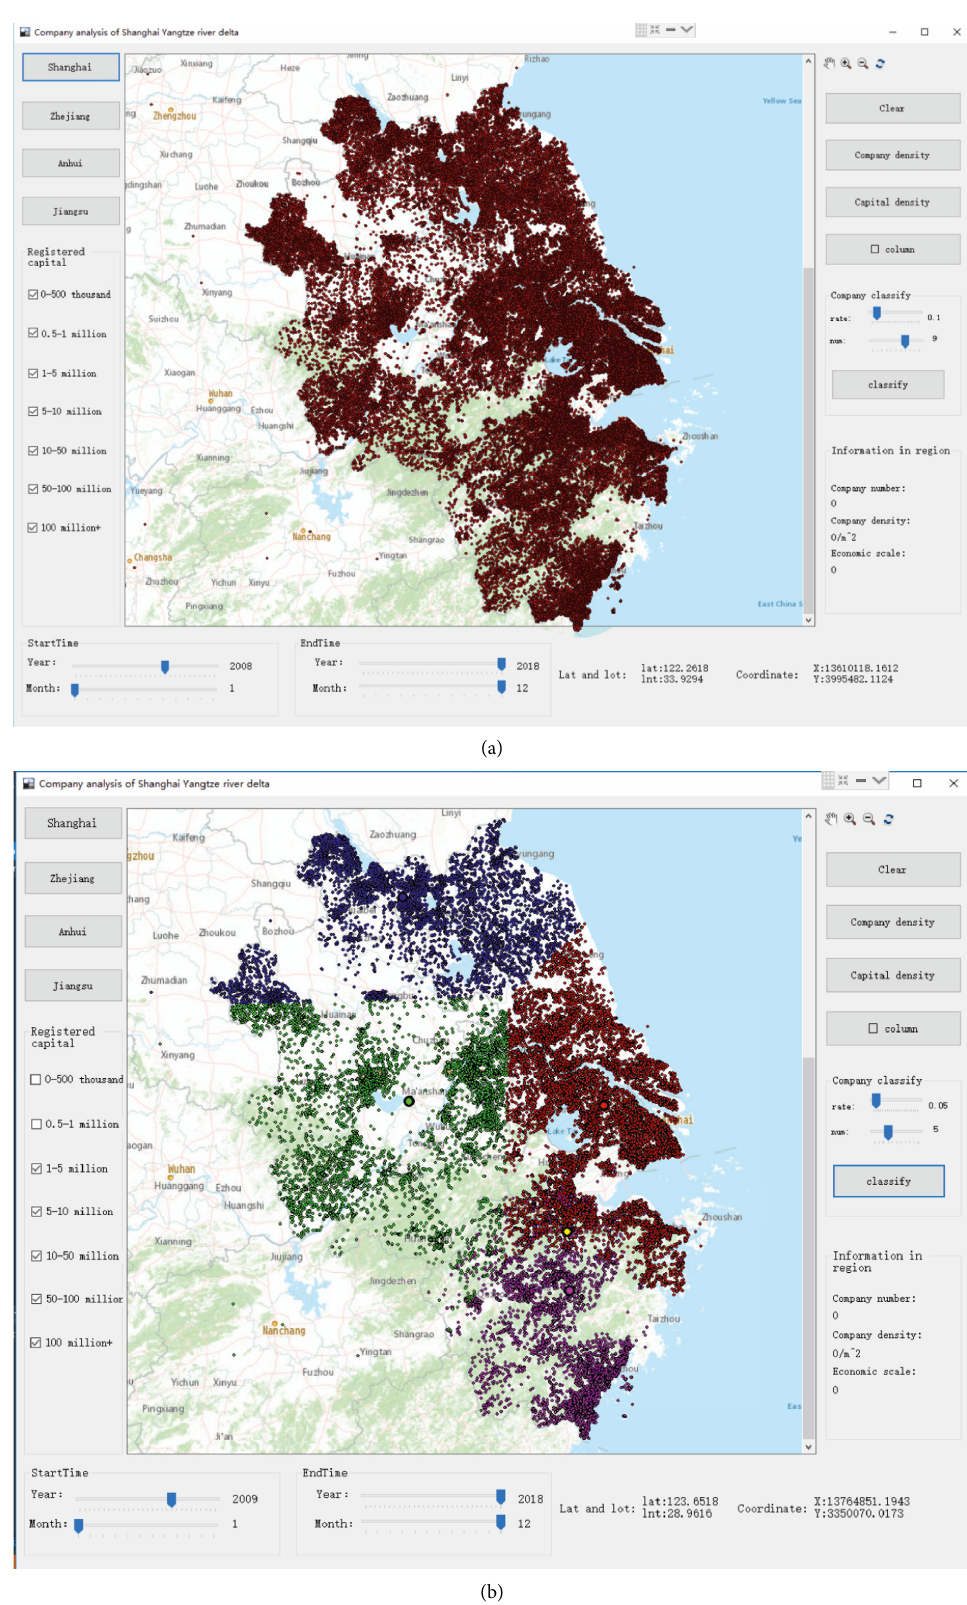
Figure 2: Data visualization interface designed in this paper. (a) Spatial distribution map of all companies collected from 2008 to 2018. (b) A result graph of clustering company data of spatial distribution using the improved k -means algorithm (the number of clusters is chosen to be